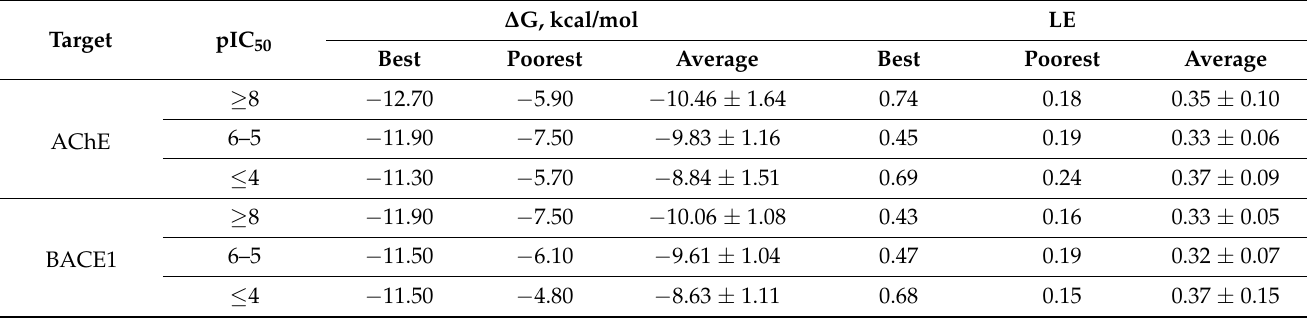
Table 3. The best (lowest binding energy), poorest (highest binding energy) and average values of calculated AutoDock Vina 1.1.2 binding energies ( ∆ G, kcal/mol) and ligand efficiencies (LE). The average values of binding energies and LEs are presented as mean ±